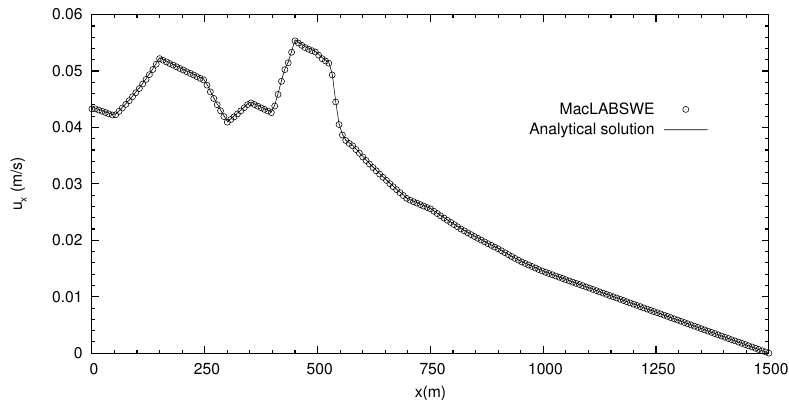
Figure 2. Comparison of velocity at t = 10,800 s when flow is in the half-risen tide with maximum positive velocities for 1D tidal flow.